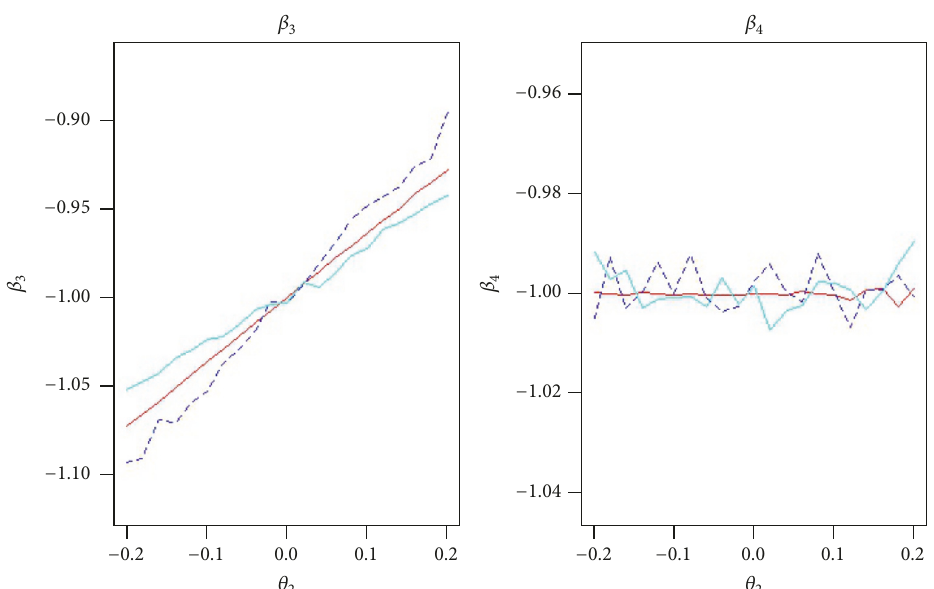
Figure 3: Comparison 1: 𝛽 = (−2,−2, −1,−1) , 𝜃 = (−0.5,0) . The blue lines (dotted lines) are simulation estimates using maximum likelihood, the red lines (solid lines) are Copas and Eguchi estimates, and the light blue lines are the LME least false estimates. √1 − 𝜌 2 . Also, the complete (𝜎 /𝜎 )𝜌(𝑌 − 𝜇 ) and 𝜎 = 𝜎 2 1 1 1 21 2 data is 𝑍 = (𝑌 1 , 𝑌 2 , 𝑅) and incomplete data is 𝑌 = (𝑌 1 , 𝑌